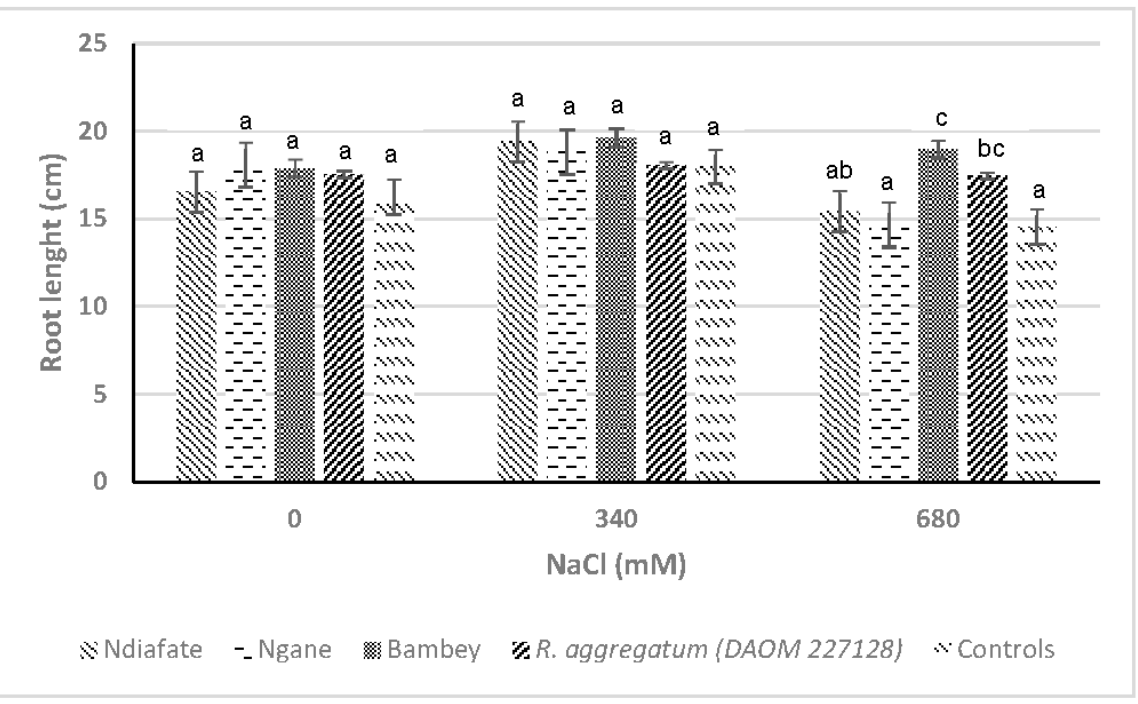
Figure 3. The effect of the AMF isolates × NaCl interaction on A. seyal root length after 30 days of culture. Ndiafate, Ngane, and Bambey correspond to high, moderate, and low salinity zones, respectively where the AMF were collected. Bars with the same letters for each variable are not significantly different at p < 0.05 (Newman–Keuls test) and error bars represent standard error of the mean ( n = 270).